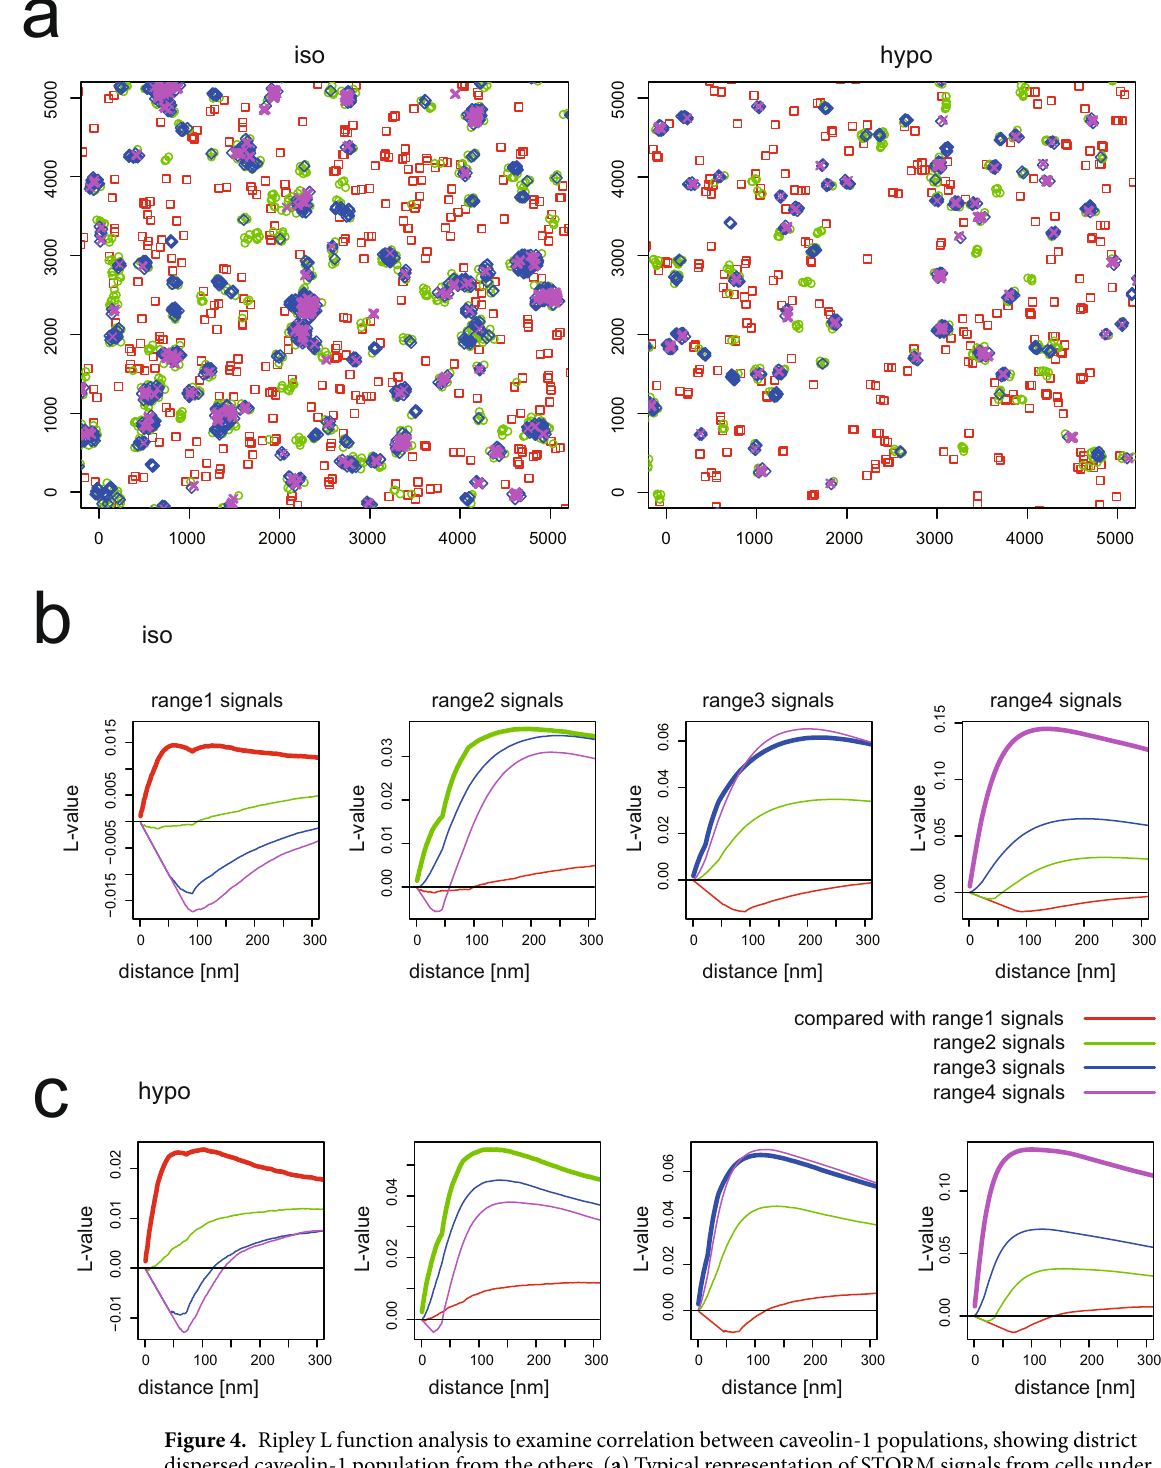
Figure 4. Ripley L function analysis to examine correlation between caveolin-1 populations, showing district dispersed caveolin-1 population from the others. ( a ) Typical representation of STORM signals from cells under isotonic and hypo-osmotic conditions for 5 min in Fig. 3. Density ranges are distinguished by colour: red, green, blue and magenta dots represent signals in the first, second, third and fourth range, respectively. ( b , c ) Multivariate Ripley’s L function analysis to examine the correlation between caveolin-1 from cells under ( b ) isotonic and ( c ) hypo-osmotic conditions in the four ranges in Fig. 3a. The leftmost panels show L function analysis with signals in the first range; a bold red line indicates autocorrelation among signals in the first range, and thin lines show cross-correlations among signals in the first range and in the second (green), third (blue) and fourth (magenta) ranges. The second, third and fourth panel shows L function analysis with signals in the second, third and fourth range, respectively. The analysis of the other cells in Fig. 3 is on Figure